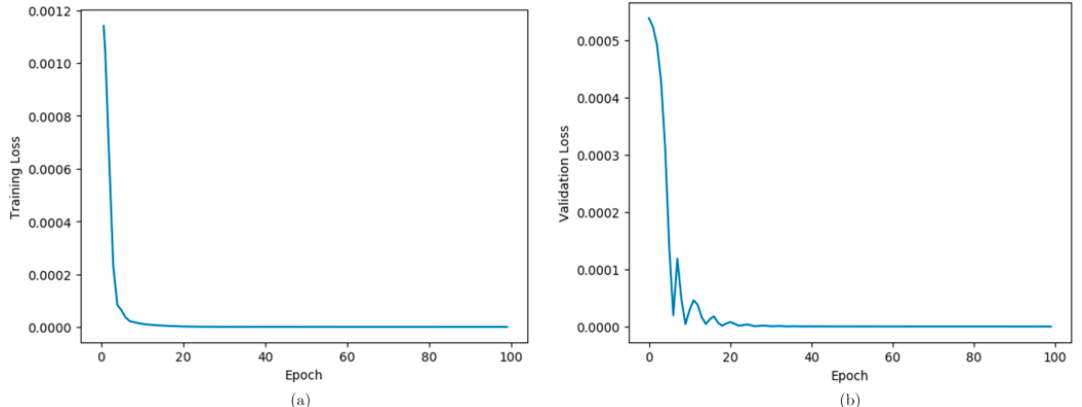
Figure 9. GPR simulation data in a single-layer background medium for training regression networks. ( a ) The MSE loss of training data; ( b ) the MSE loss of validation data.